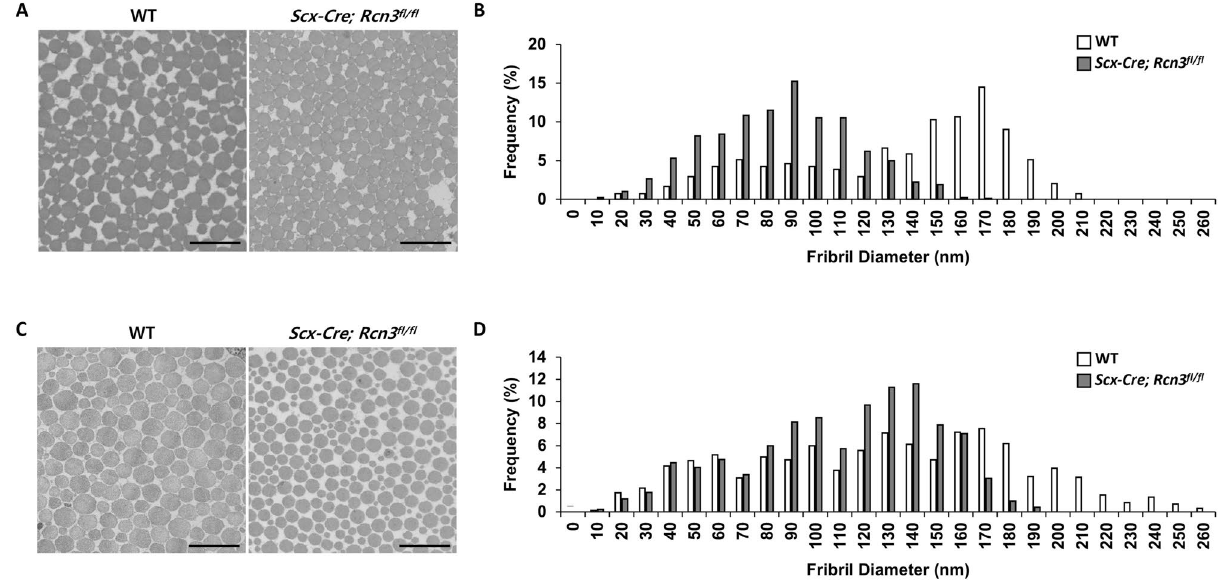
Figure 3. EM image of patellar ( A ) and Achilles ( C ) tendons and frequency graph of patellar ( B ) and Achilles ( D ) tendons of wild-type mice and Scx-Cre; Rcn3 fl/fl littermates at P60. (Scale bar indicates 500 nm ( A , C ), n = 3